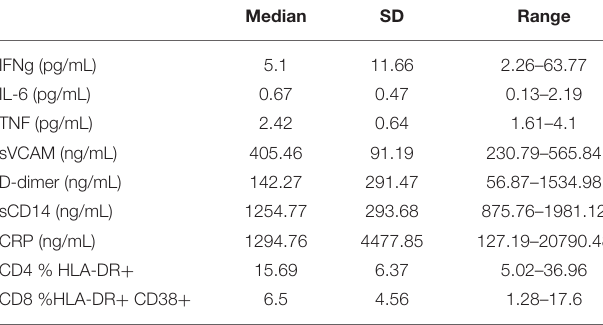
TABLE 1 | Participant clinical parameters and demographics ( n = 28). TABLE 2 | Summary of plasma inflammation associated